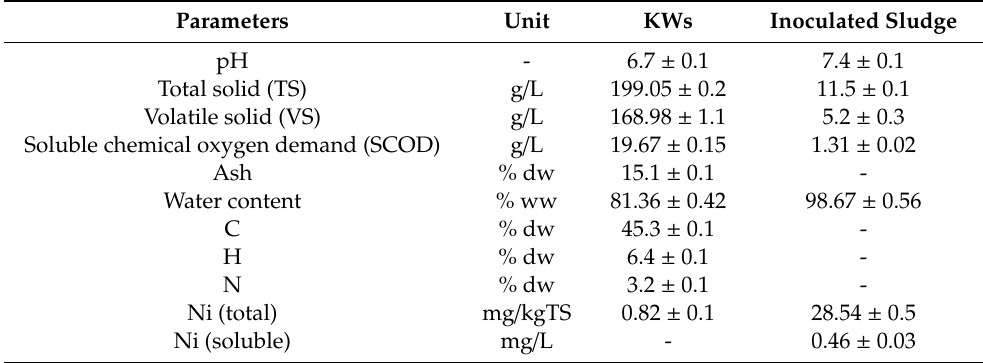
Table 1. Characteristics of KWs and inoculated